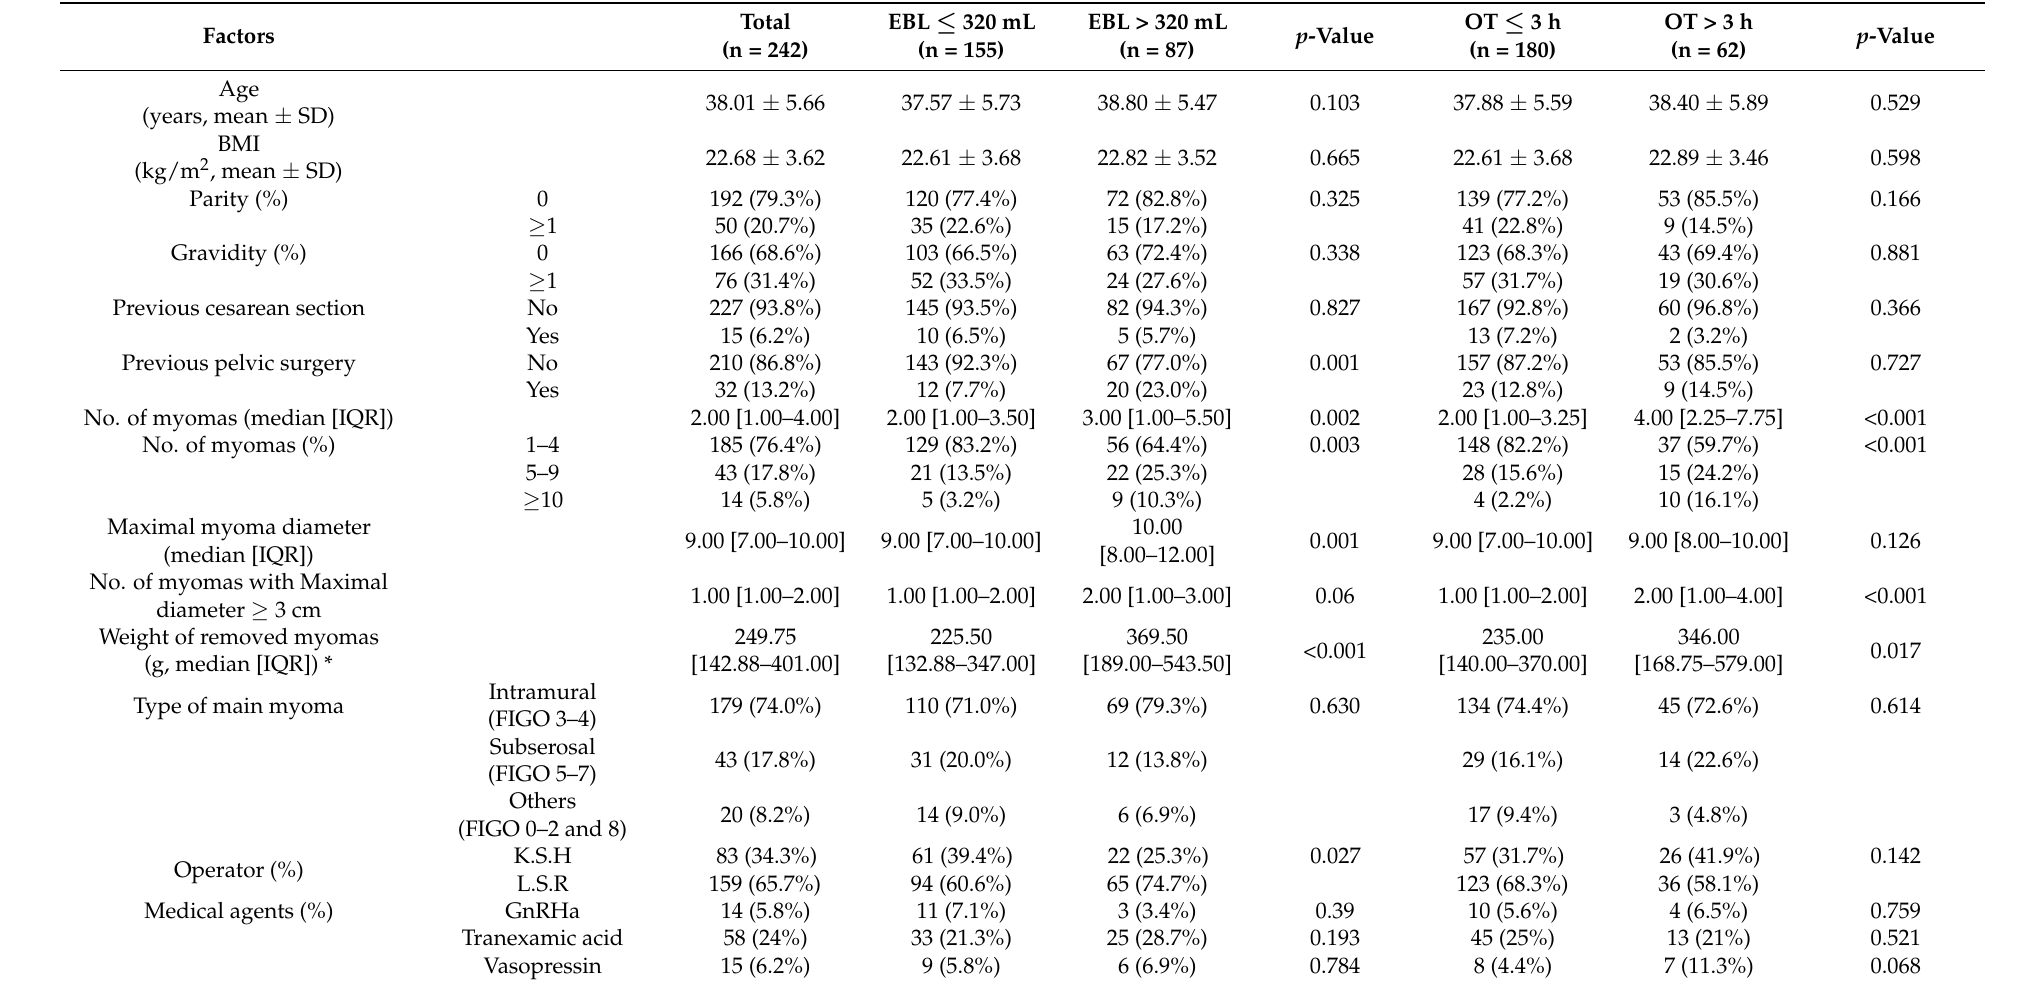
Table 1. Baseline characteristics of